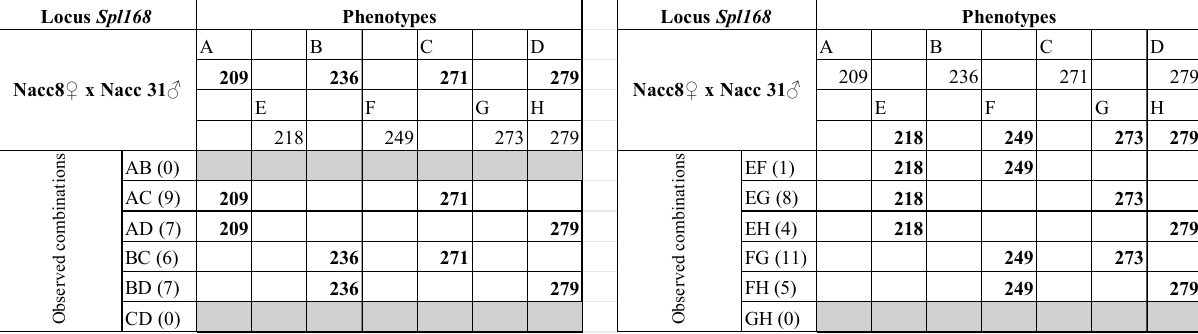
Figure A1. Total segregation results. Single-locus microsatellite inheritance for each studied sturgeon family. Microsatellite alleles of parents are reported as sizes in bp. For families in which both parents are informative, two different schemes are shown. The 4 alleles of the informative parents are highlighted in bold and marked with capital letters A, B, C, D for females and E, F, G, H for males, also used to label allele combinations observed in the progeny. The number of F1 in which each combination has been observed is reported in brackets. Missing combinations are marked in grey.